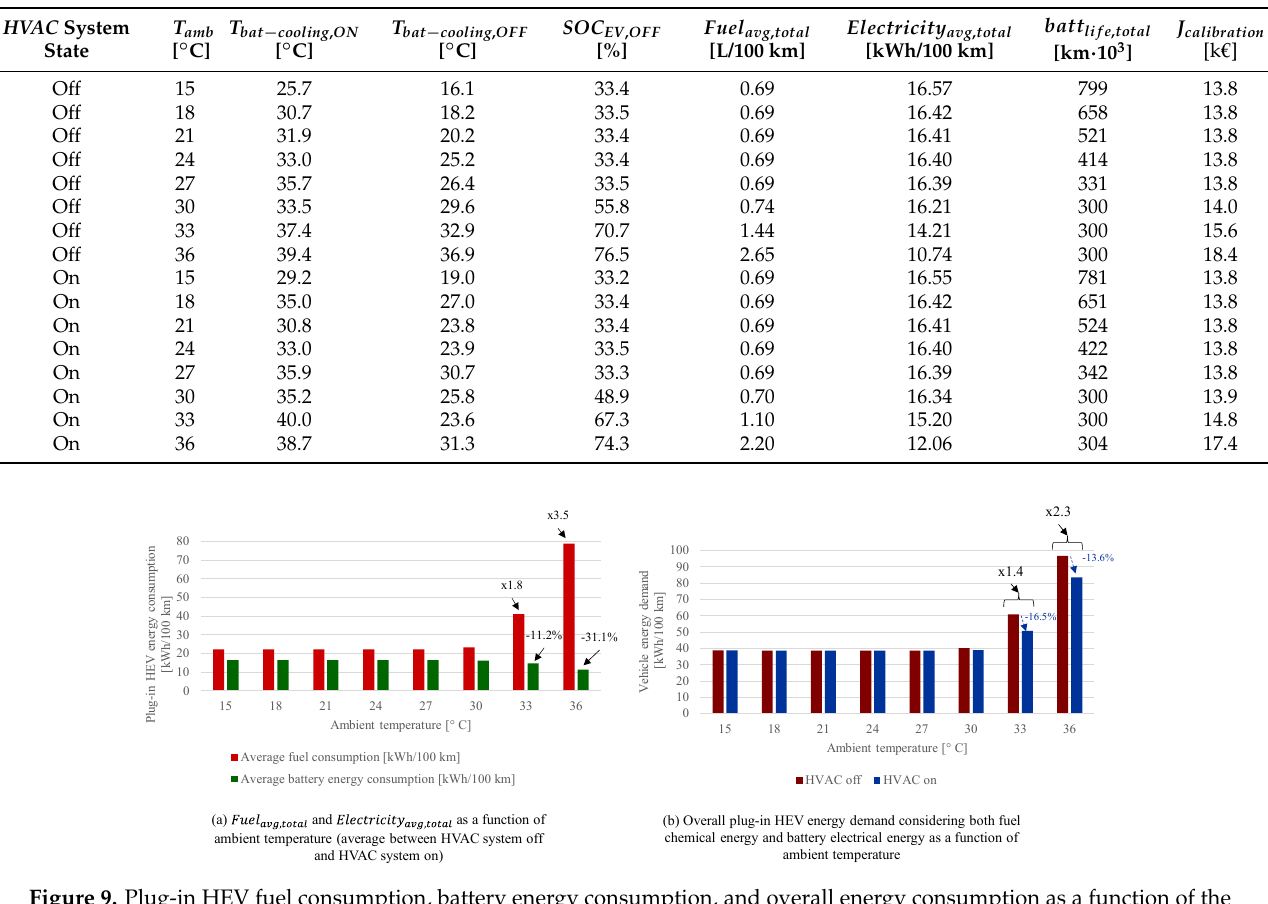
Table 7. Calibrated thermal and energy management parameters and HEV performance in terms of energy consumption and predicted battery lifetime as a function of the ambient temperature and HVAC system state.